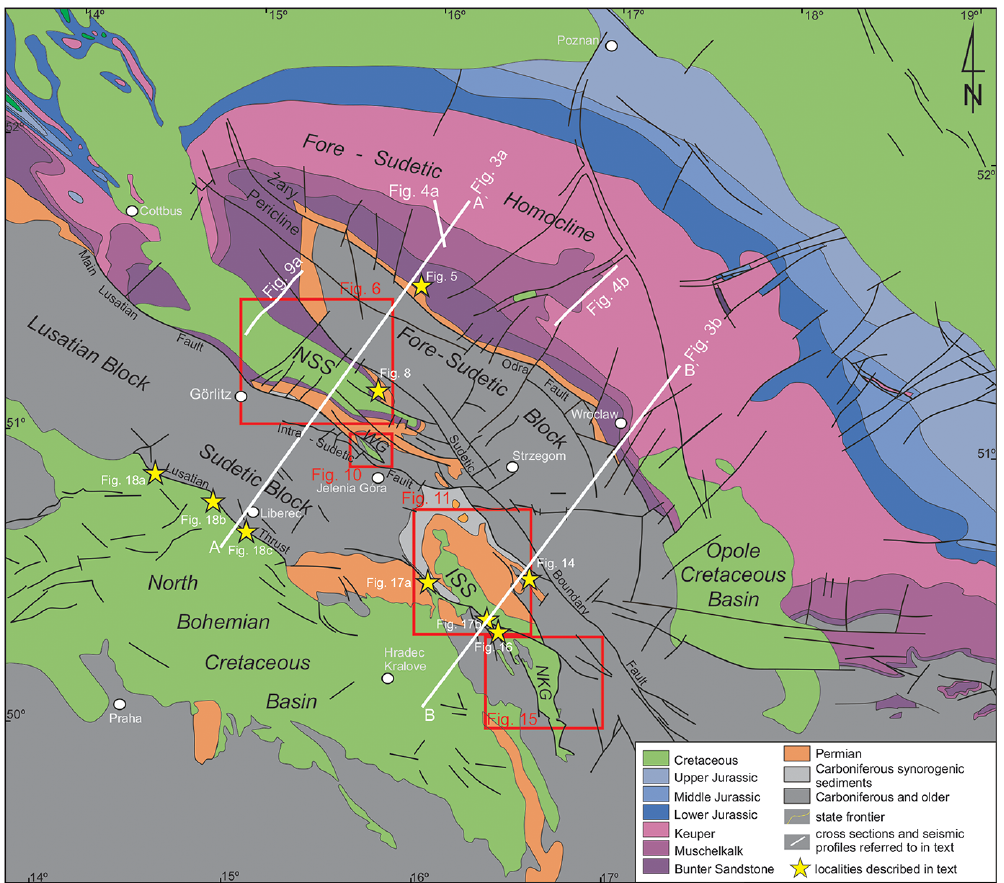
Figure 2. Geological map without Cenozoic of NE margin of the Bohemian Massif and its surroundings in SW Poland and N Czechia (simplified after Dadlez et al., 2000). ISS – Intra-Sudetic Synclinorium; NKG – Nysa–Králiky Graben; NSS – North Sudetic